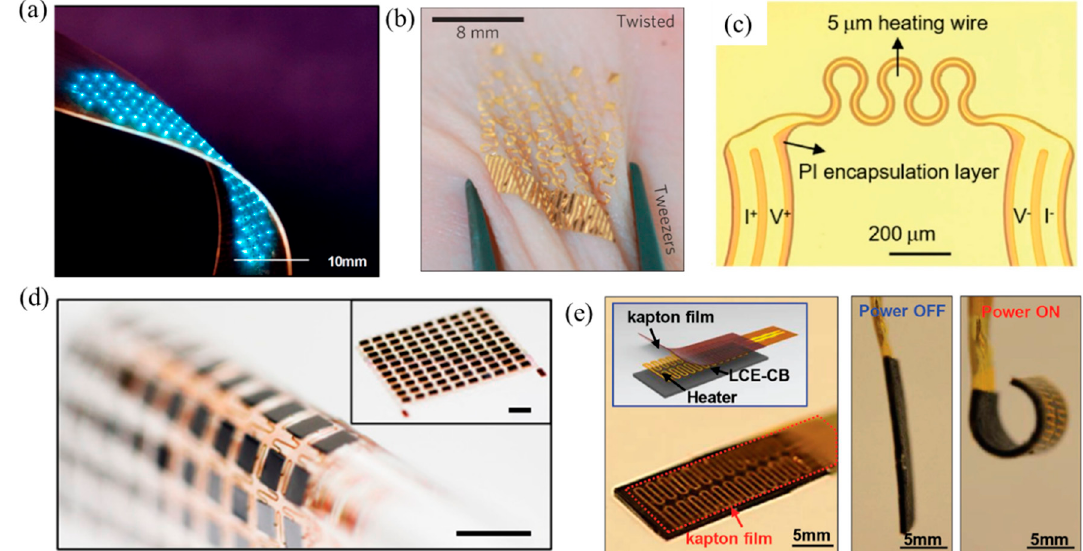
Figure 1. Examples of flexible inorganic electronic devices. ( a ) A flexible inorganic microscale light-emitting diode ( µ -ILED) display [1]. ( b ) An epidermal temperature sensor array in a twisting motion [2]. ( c ) A flexible and stretchable 3 ω sensor [3]. ( d ) A soft, thin skin-mounted power management system [4]. ( e ) A soft ultrathin electronics enabled for fully soft robots [5].